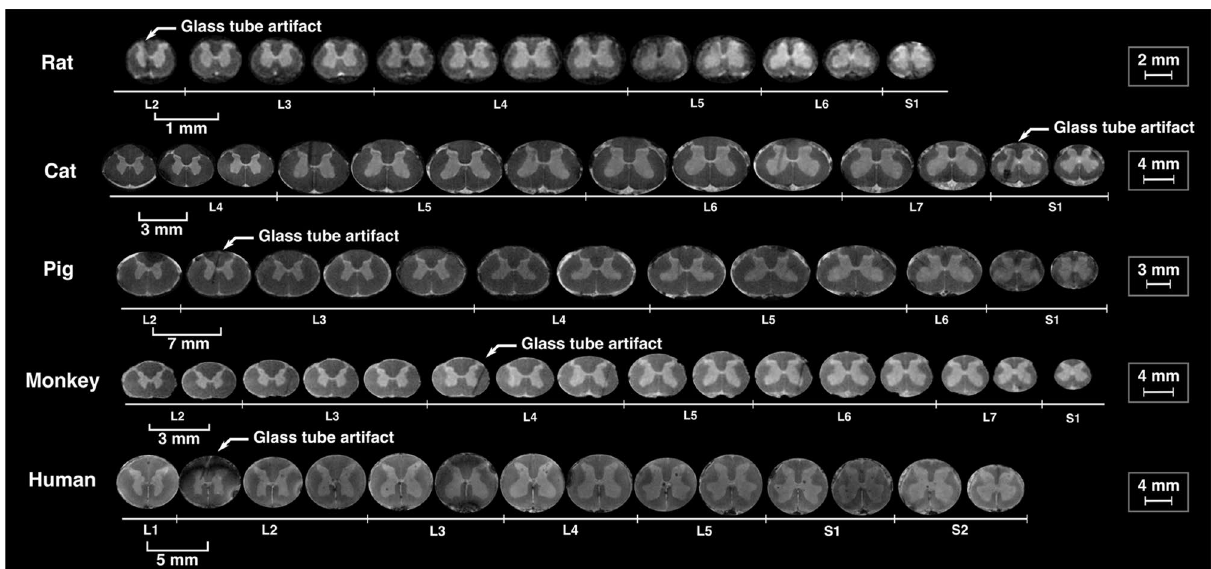
Figure 6. Sequential cross sections (T 2 *-weighted MRIs) from the lumbosacral enlargement of the spinal cords of rat, cat, pig, monkey, and human, spaced apart by 1, 3, 7, 3 and 5 mm, respectively. Scale bars for each species are shown on the right. The artifacts (arrows) are the locations of the glass markers. Images of the spinal cords of rats, cats, pigs, and humans were acquired using a 4.7 T scanner. Images of the spinal cords of monkeys were acquired using a 3 T scanner.